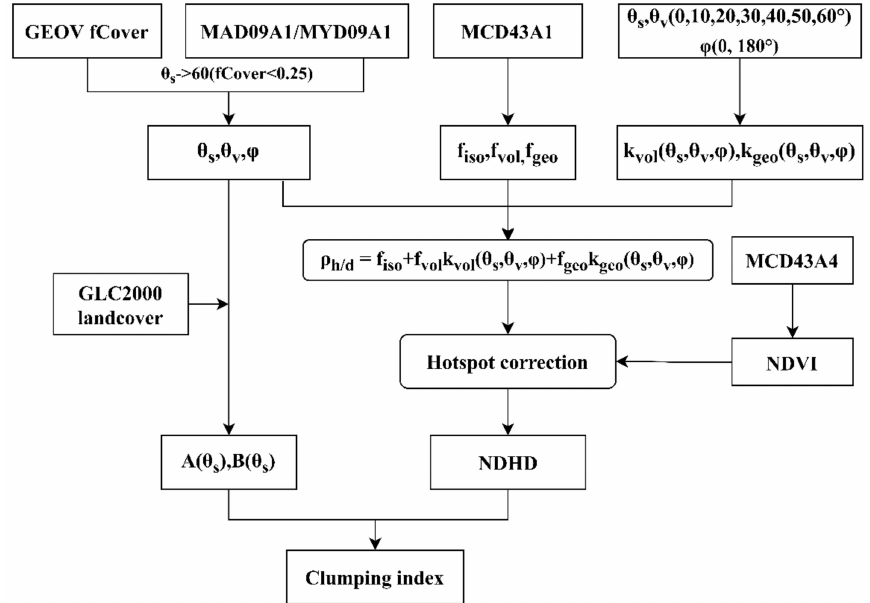
Figure 1. The procedure of the CI retrieval method based on the normalized difference between the hotspot and dark spot (NDHD) method. See Table 1 for a description of input data. The SZA is an average value between Terra and Aqua overpasses in their overlapping date obtained from observation information described in Section 2.1. f iso , f vol , and f geo are kernel parameters provided by the red band of MODIS43A1 products. k vol and k geo are parts of the bidirectional reflectance distribution function (BRDF) [30]. The expression